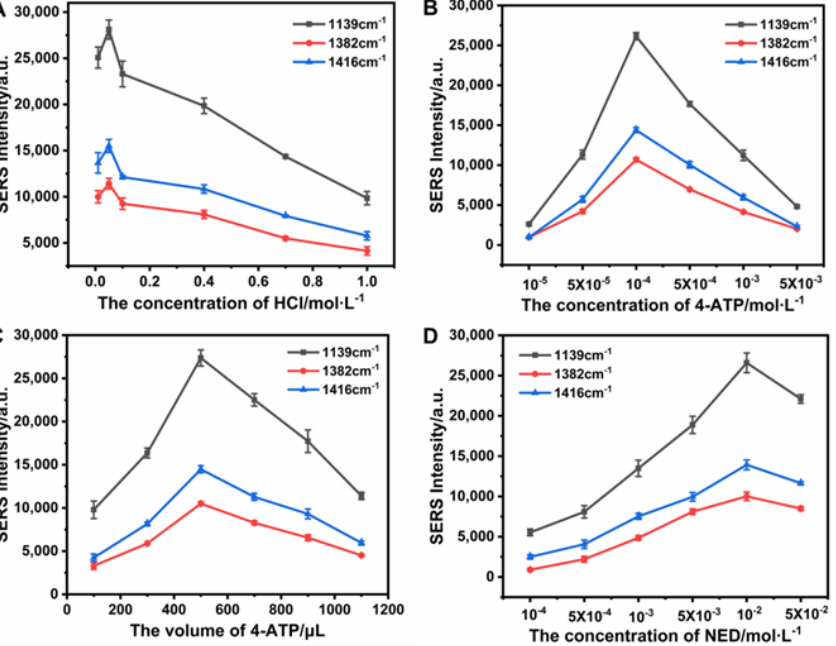
Figure 4. Optimization of ( A ) the concentration of HCl, ( B ) the concentration of 4-ATP, ( C ) the volume of 4-ATP, and ( D ) the concentration of NED. The error bars were derived from the RSD of five measurements.